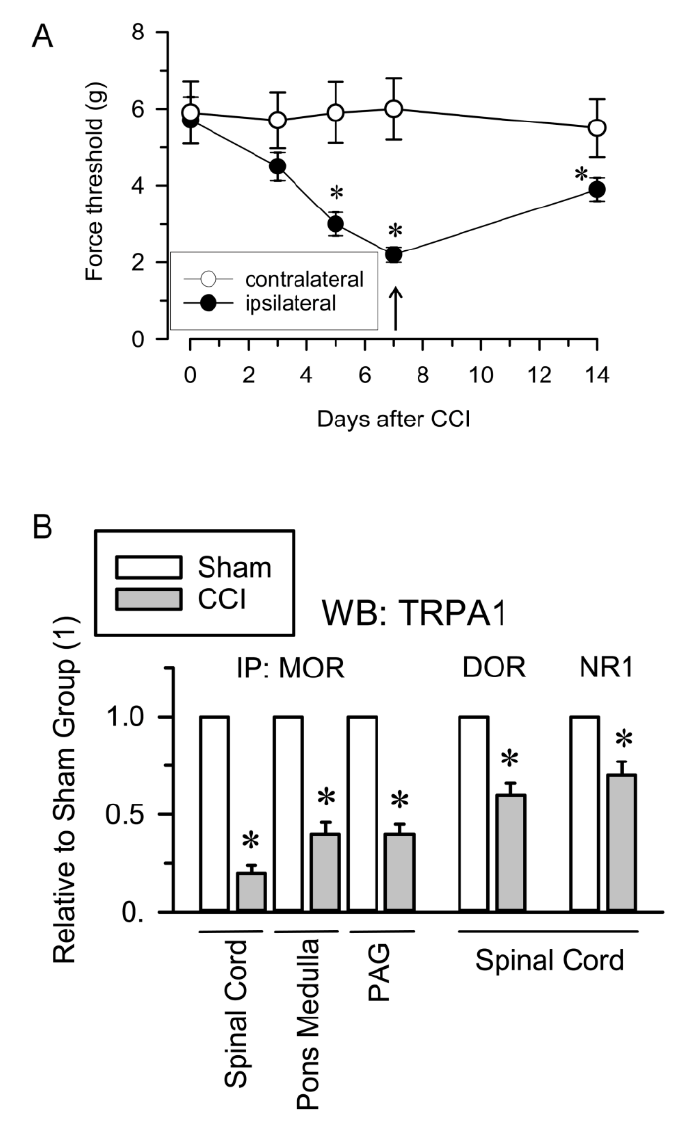
Figure 4. TRPA1 associations with opioid receptors and NMDARs in the CCI model of neuropathic pain. ( A ) Induction of mechanical allodynia. Chronic constriction injury (CCI) of the sciatic nerve caused neuropathic pain in mice. The paw withdrawal thresholds of the contralateral and ipsilateral paws of the mice were measured before (indicated as 0) and 3, 5, 7 and 14 days after surgery. The force (in grams) at which the mice withdrew their paws in response to von Frey hair stimulation was determined as an index of mechanical allodynia. The data are the mean ± SEM of six mice. * Indicates significant difference compared to the nociceptive threshold of the sham-operated control group on day 0 (7th after surgery); p < 0.05. ( B ) Seven days after surgery, sham and CCI mice were killed and synaptosomal fractions from different neural areas were obtained. The MOR, DOR and NR1 subunits were immunoprecipitated from the solubilized membrane preparations and coprecipitated TRPA1 was analyzed by Western blotting. * Indicates significant difference compared to the sham control group, p < 0.05. Further details in Figure 2, Supplementary Materials Figure S6 and Section